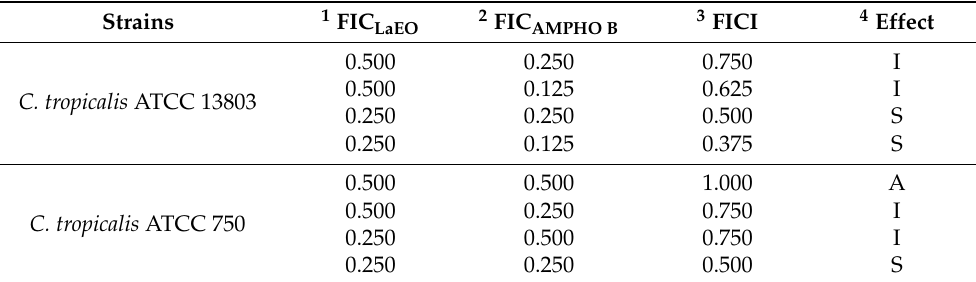
Table 10. Modulatory effect of LaEO on the antifungal activity of amphotericin B (AMPHO B) on Candida